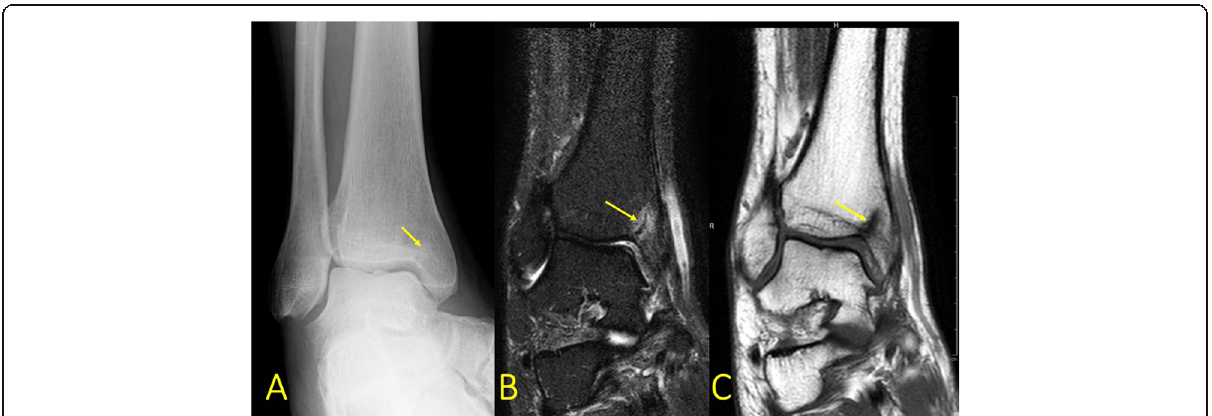
Fig. 3 A 57-year-old male with pain in the medial malleolus without a history of trauma. a Radiograph, mortise view, b PD FS coronal image, and c T1-weighted coronal image. MRI showed an occult fracture of the medial malleolus (arrow) which in retrospect was visible on the radiographs. There is a minor irregularity of the cartilage signal in the subchondral central part of the talar trochlea, probably after previous injuries